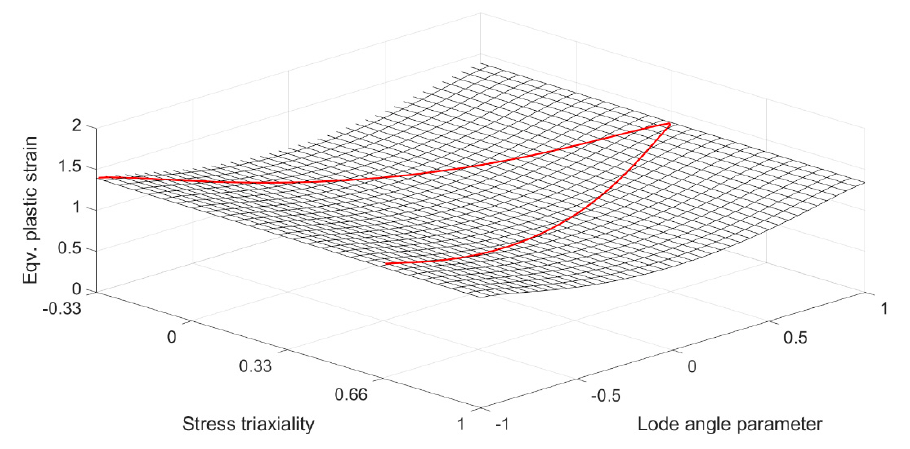
Figure 10. HC fracture locus for JIS G3131 SPHC.